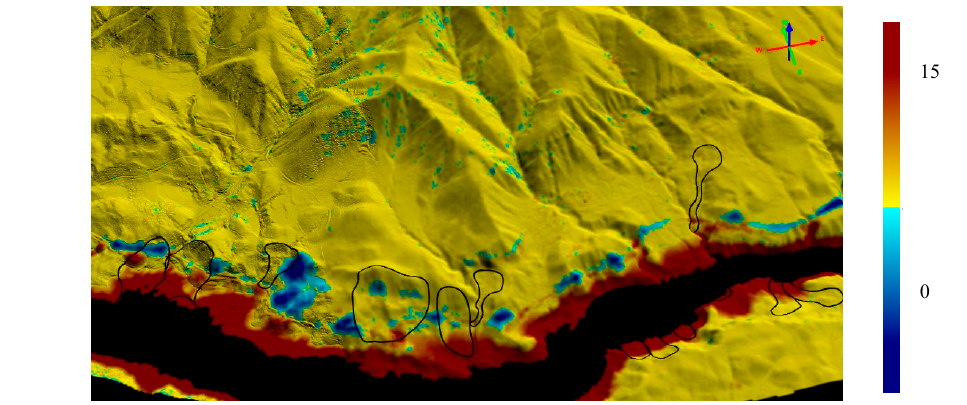
Figure 15. The ortophotos ( a , b ), ML outputs ( c – e ), and plots of the Euclidian di ff erences ( f , g ) obtained